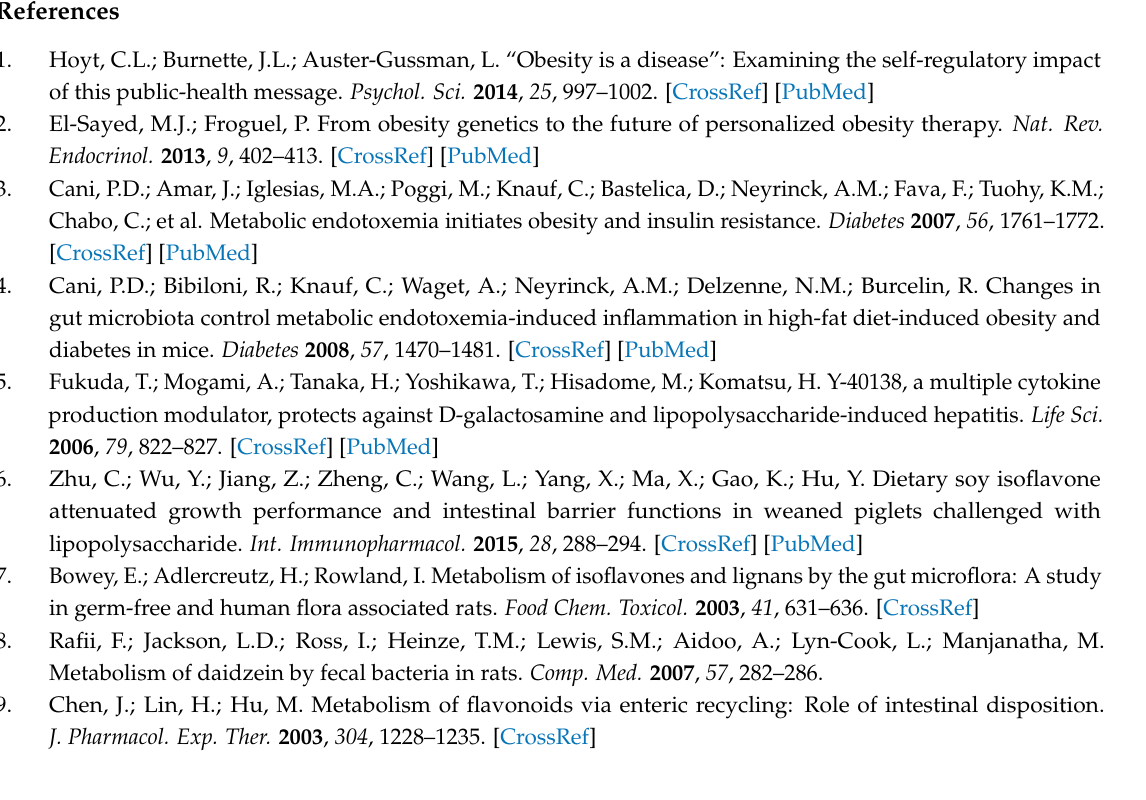
Figure S2: Bacterial taxonomic analysis of intestinal bacterium from each rat in the phylum, Figure S3: Relative abundance of several microbiota in the